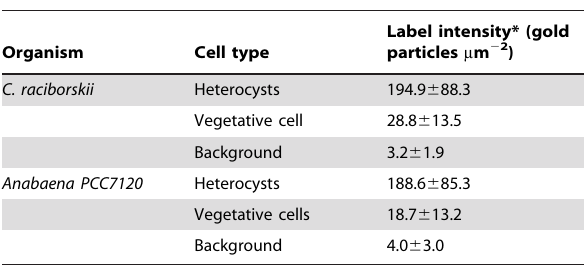
Table 2. Relative quantities of NifH in intact trichomes of C. raciborskii and Anabaena PCC7120 assayed by immunogold- TEM